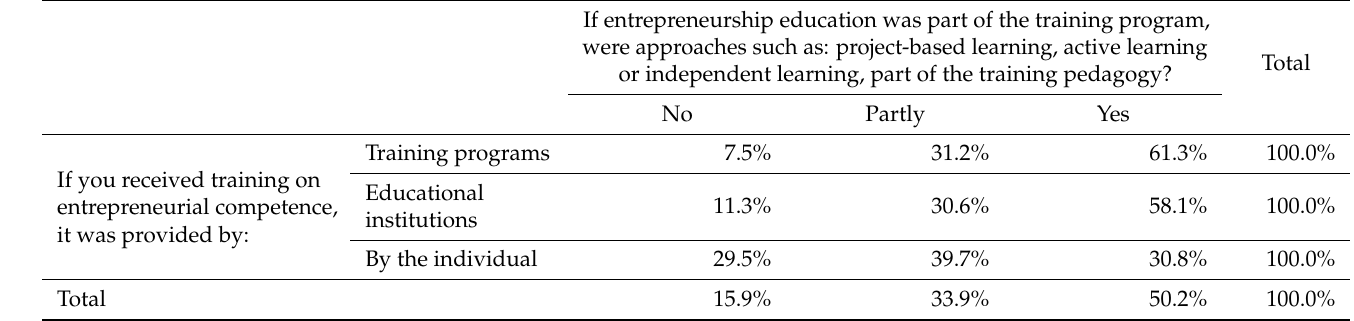
Table 3. Crosstabulation of (Q8) and